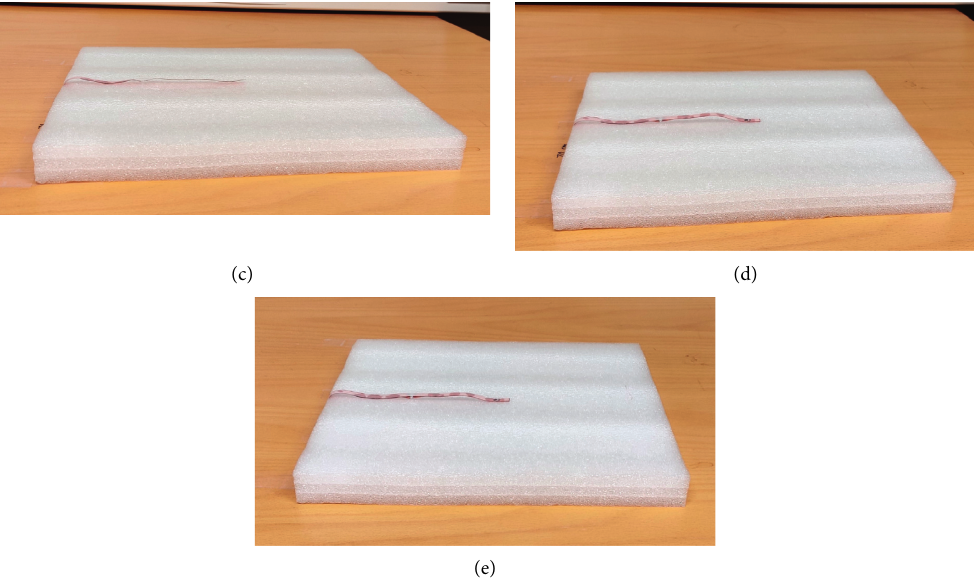
Figure 12: Bending of a sensor tag when exposed to different temperatures: 45 ° C (a), 55 ° C (b), 60 ° C (c), 65 ° C (d), and 70 ° C